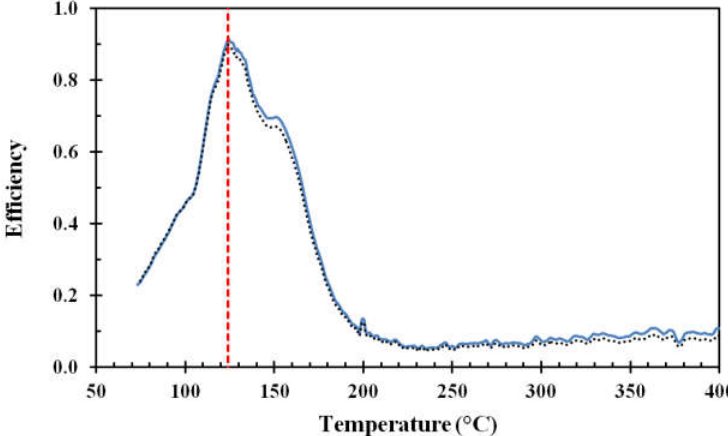
temperature. The temperature at the maximum cooling rate is marked ( red ).